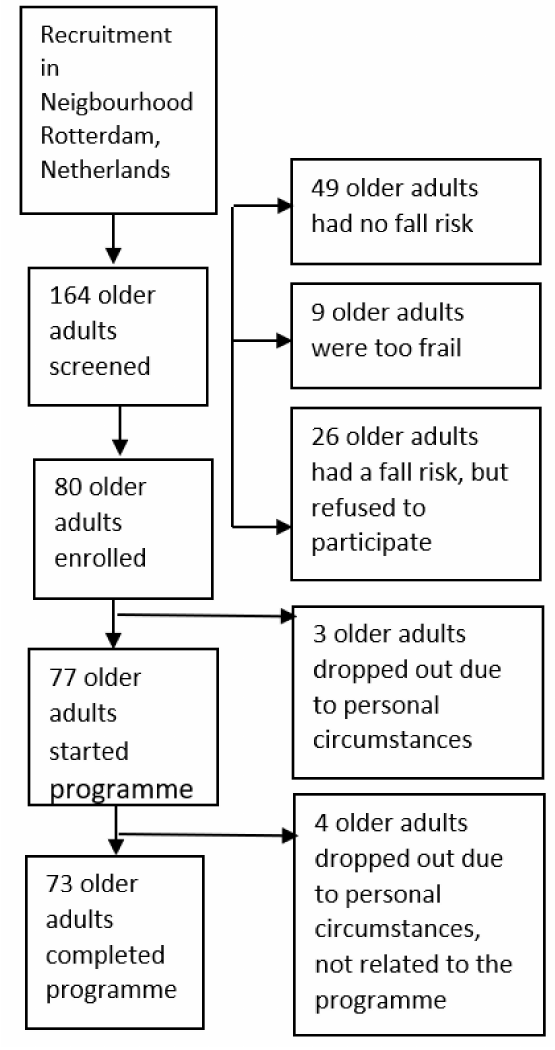
Figure 3. Flow-diagram of recruitment and reach of